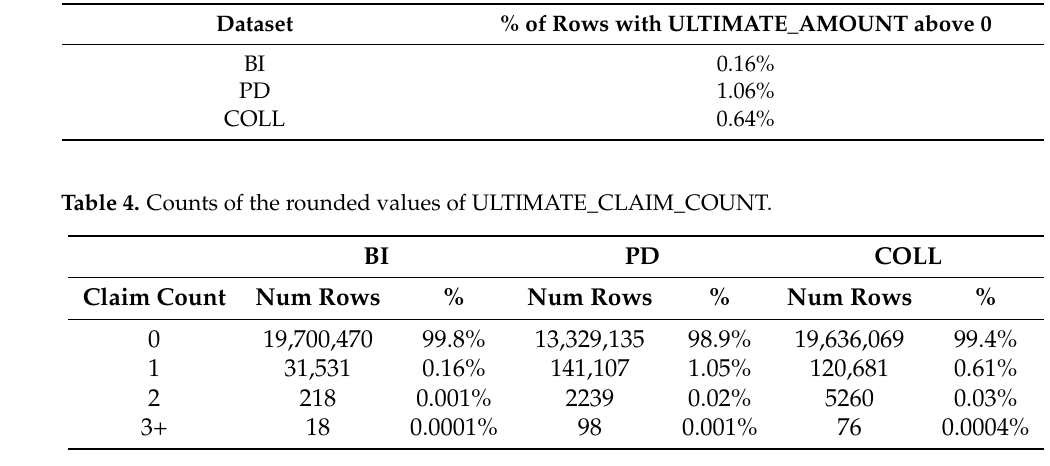
Table 3. Percentages of positive ULTIMATE_AMOUNT in the different datasets.